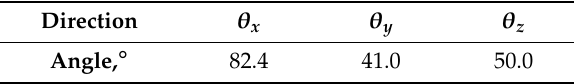
Table 2. Principal direction of disk harrow